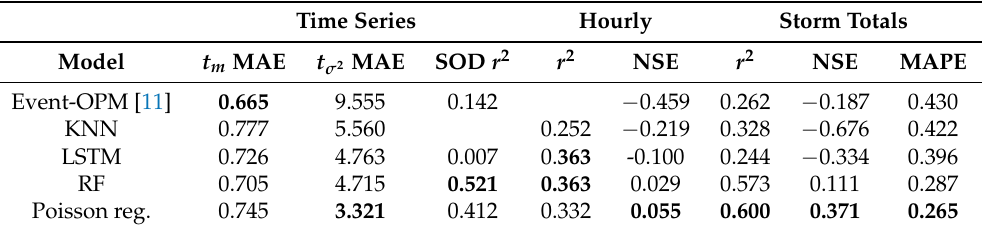
Table 1. The performance of each model across several metrics and averaged across storms. From left to right: mean absolute error (MAE) in t m , MAE in t σ 2 , the r 2 of SOD predictions, hourly r 2 and NSE, and storm-total r 2 , NSE, and MAPE. The MAPE is unavailable for stormwise total outage predictions because there are hours with zero actual outages. Some correlation metrics could not be computed for some models because of constant predictions. The best model for each metric is bolded. Time Series Hourly Storm